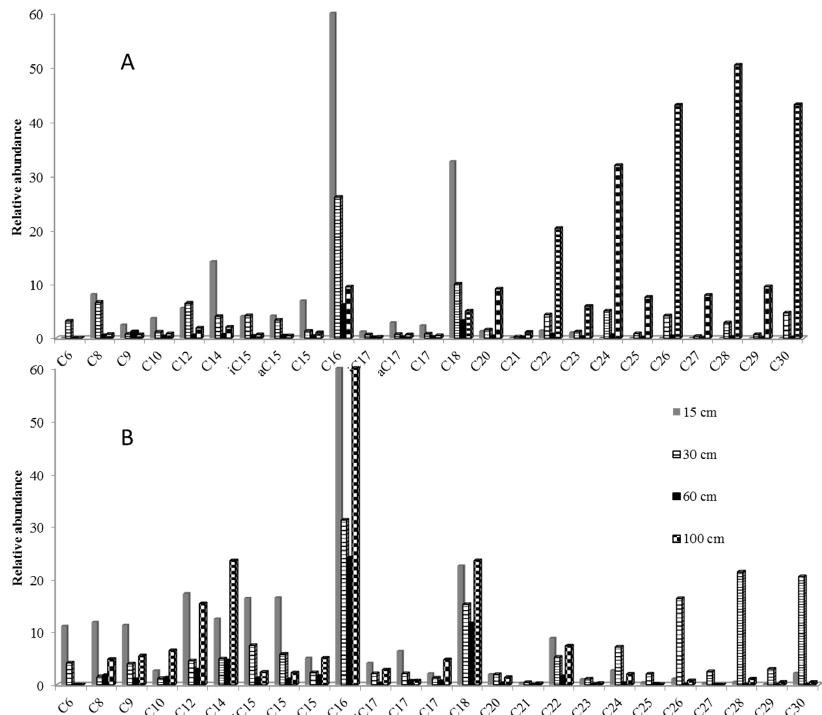
Figure 2. Thermochemolysis of 500 mL reference ( A ) and amended ( B ) soil solutions from 15 to 100 cm depth after a 40 °C evaporation step (TMAH 25%, 600 °C).